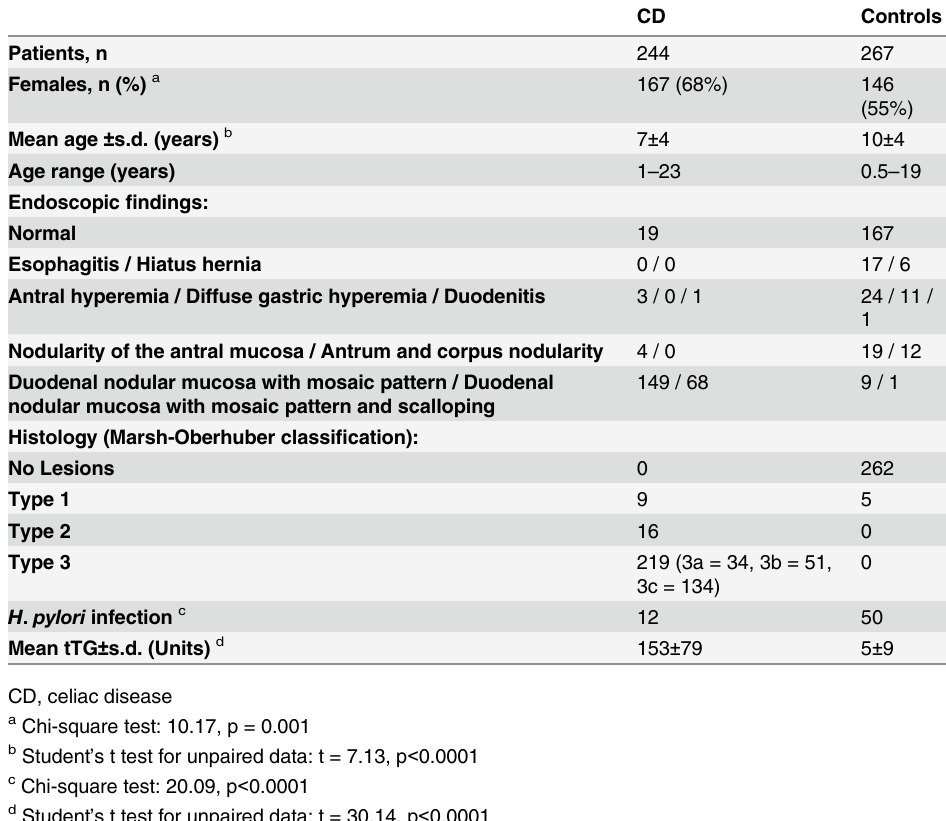
Table 1. Patients ’ details and clinicopathological characteristics. CD Controls Patients, n 244 267 Females, n (%) a 167 (68%) 146